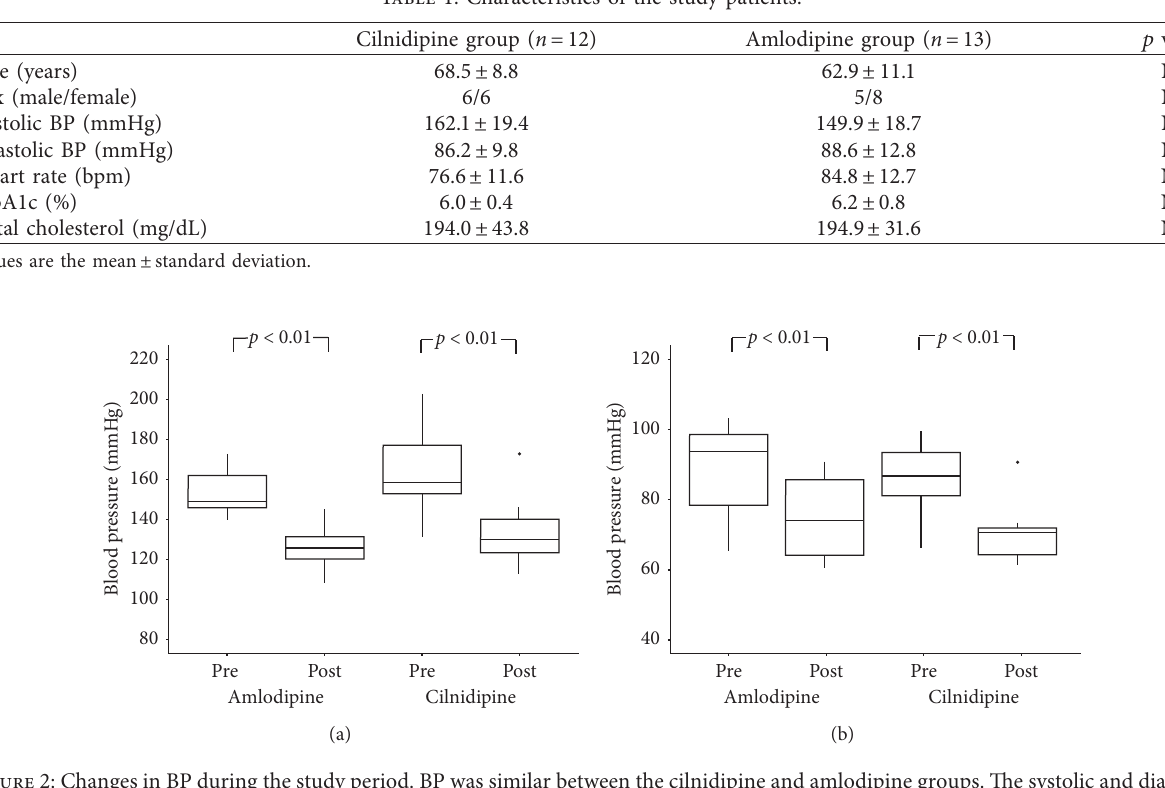
Figure 2: Changes in BP during the study period. BP was similar between the cilnidipine and amlodipine groups. The systolic and diastolic BP values were significantly reduced in both groups after 6 months of treatment. BP, blood pressure. (a) Systolic blood pressure. (b) diastolic blood pressure.